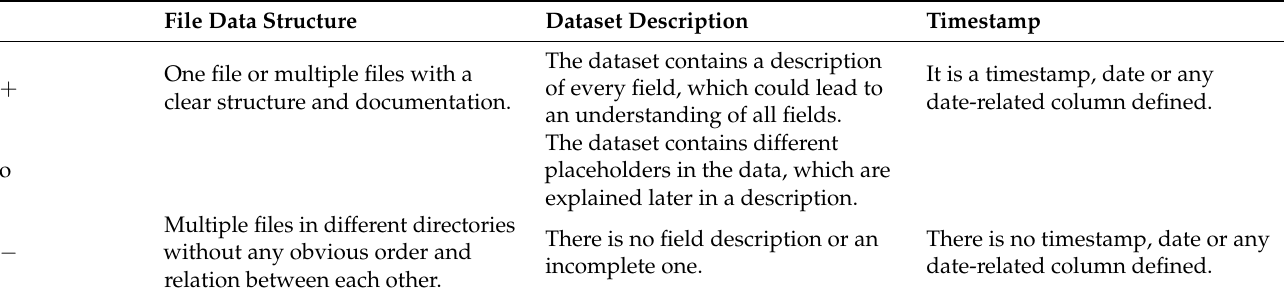
Table 5. Description of the column “Data Structure” with ( FileDatastructure/DatasetDescription/ Times- tamp ) from Table